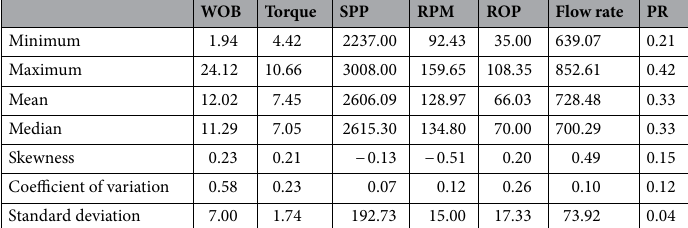
Table 3. Statistics of the data used to build the models.